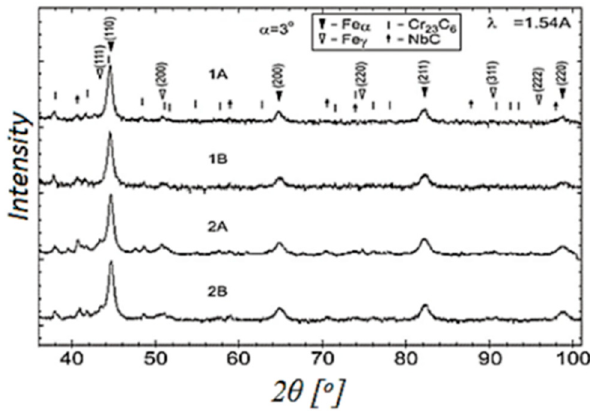
Figure 10. Diffraction pattern of a sample taken from the crane beam.